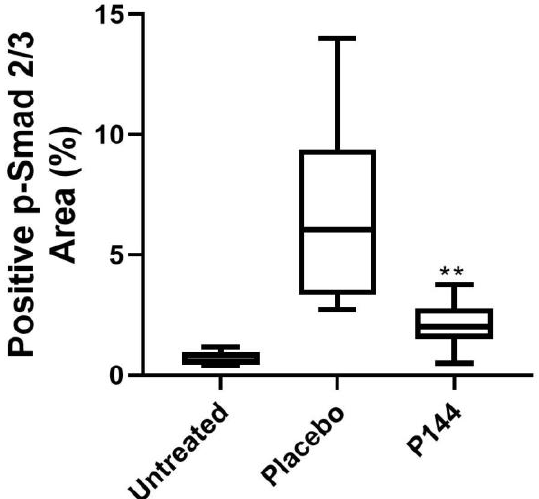
Figure 6. Immunohistochemical positive quantification of P-Smad2/3 in stained slides of rabbits’ muscle tissue that underwent brachytherapy. Placebo vs. P144 treated animals’ TGF- β signaling activation measured as positive detection of p-smad 2/3. Statistical significance ** p < 0.01.